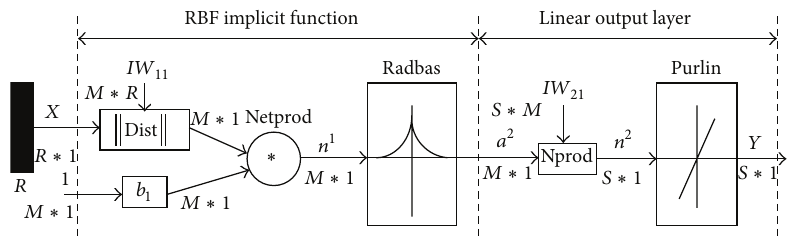
Figure 1: The structure of GRNN model based on Matlab